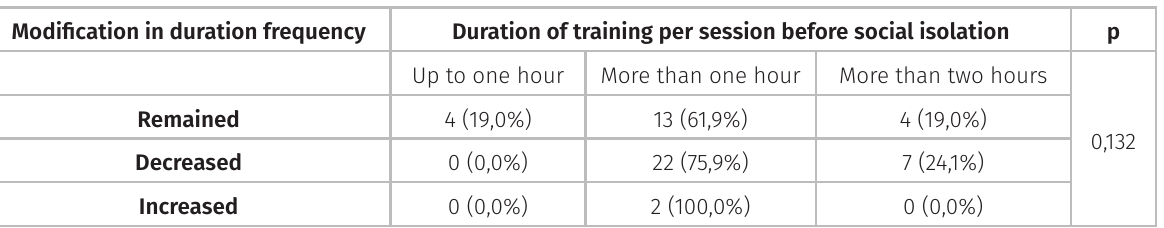
Table III. Frequency of duration of the athletes training sessions.